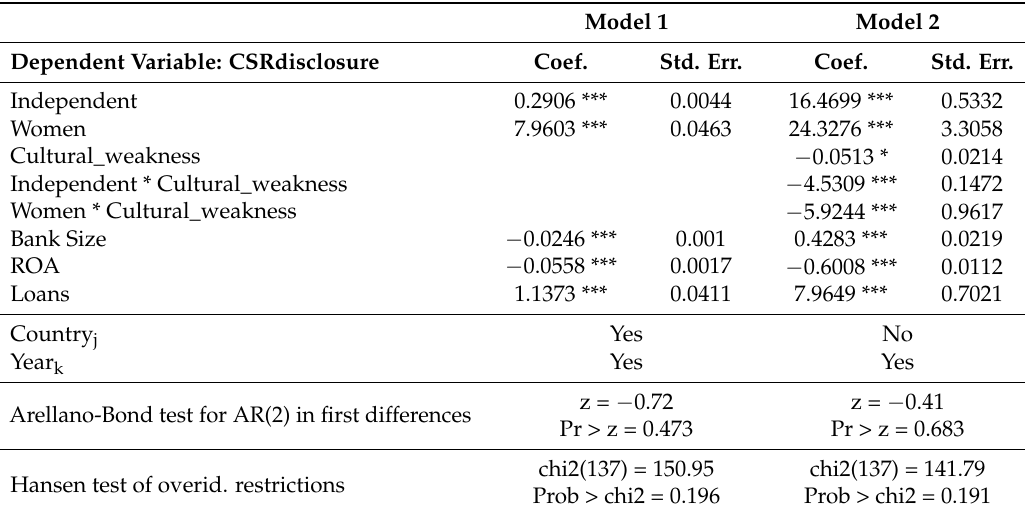
Table 6. Effect of independence and diversity of the board on CSR disclosures.